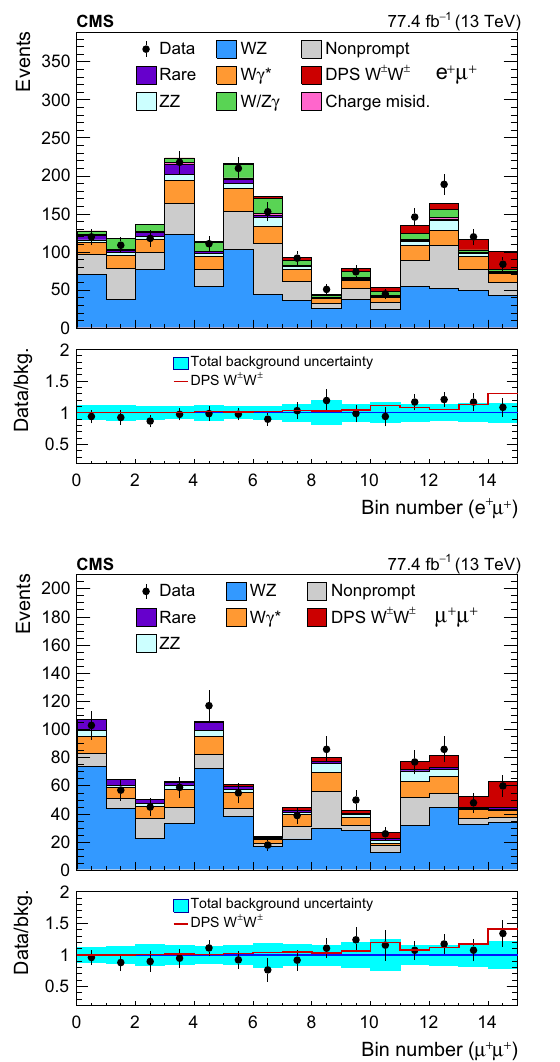
Fig. 2 Distribution of the final BDT classifier output for e μ (upper) and μμ (lower) final states, in the positive (left) and negative (right) charge configurations. Observed data are shown in black markers while the backgrounds and signal are shown in colored histograms with their postfit yields. The SHS W ± W ± and WWW contributions are grouped